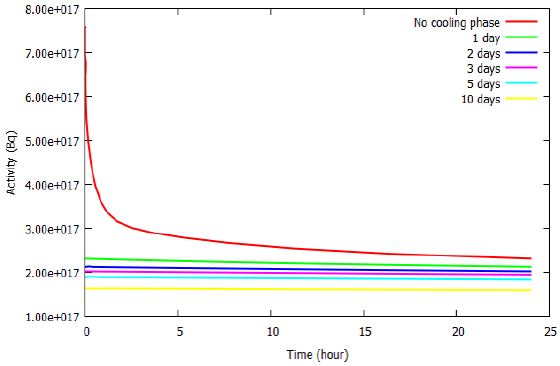
Figure 2. The total activity associated to the fluorination step as a function of time for di ff erent cooling